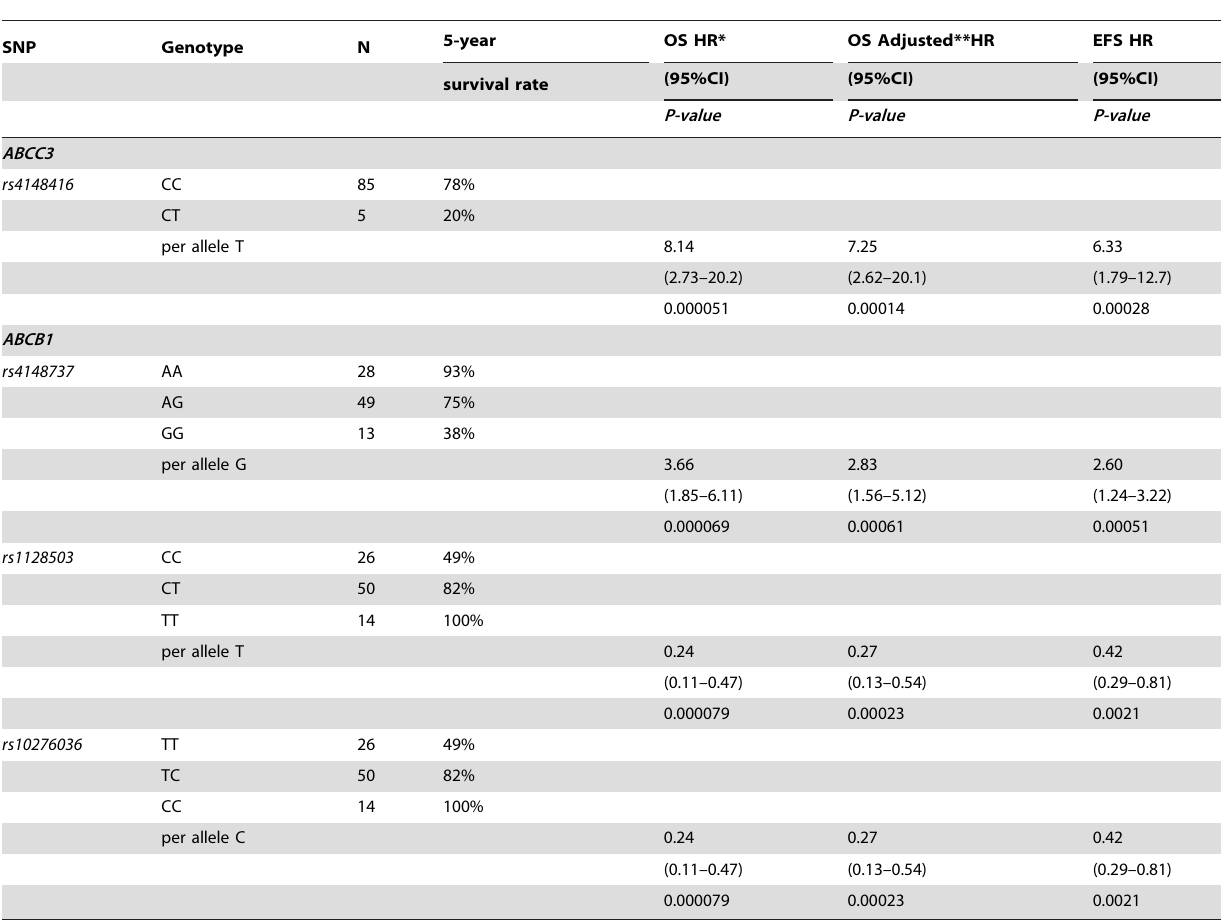
Table 2. Genes and polymorphisms associated with overall survival (OS) and event free survival